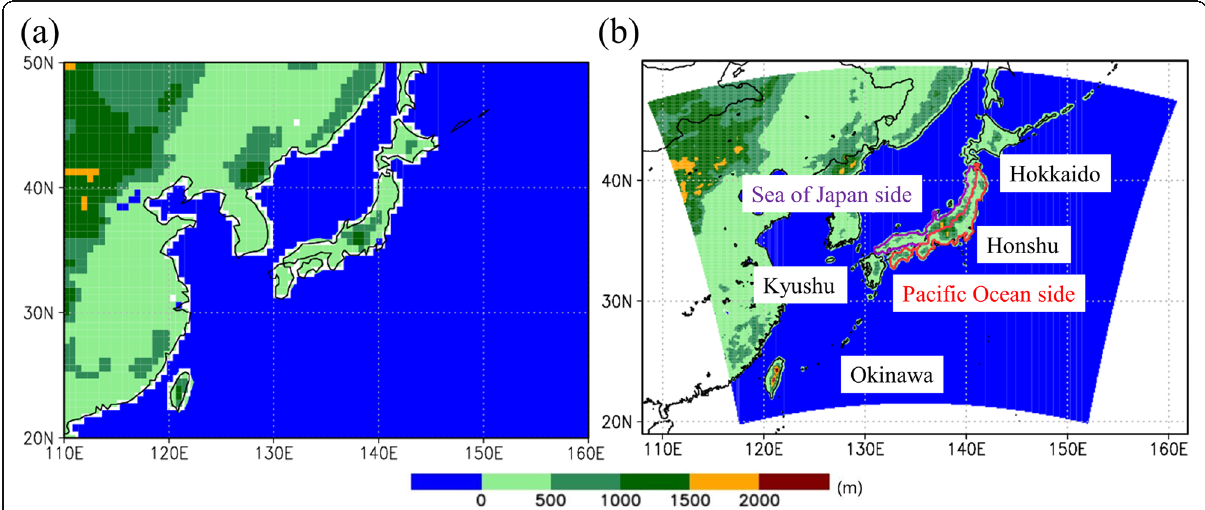
Fig. 1 Model topographies of a MRI-AGCM and b NHRCM20. The right panel shows several area names, which are referred to in the text. Red line indicates the Pacific Ocean side in Honshu, and purple line indicates the Sea of Japan side in